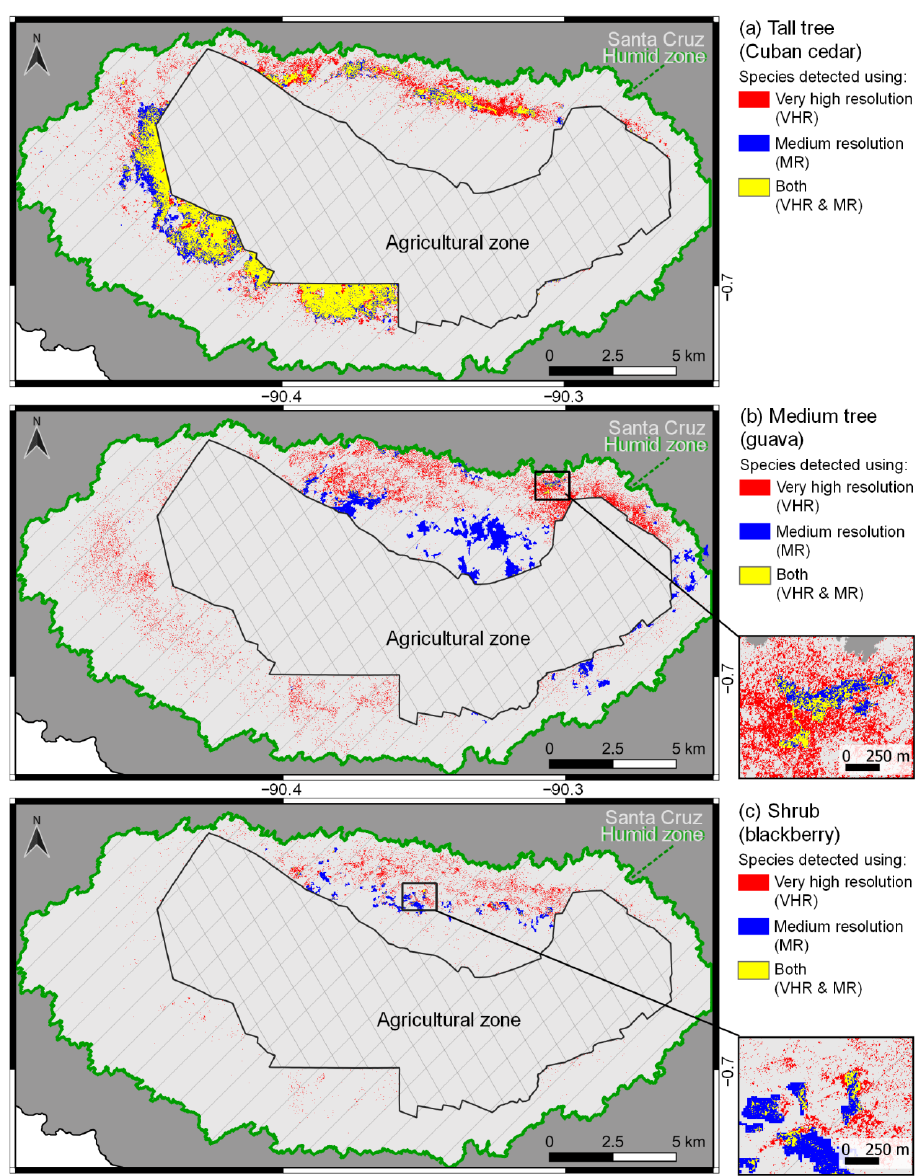
Figure 2. Comparison of species distribution maps, using very-high-resolution (red) and medium- resolution (blue) satellite imagery or both resolutions (yellow) for: ( a ) tall tree growth form (Cuban cedar); ( b ) medium tree growth form (guava); and ( c ) shrub growth form (blackberry) in the humid zone of Santa Cruz, Galapagos. Very-high-resolution maps can be found in the supplementary ma- terials section.